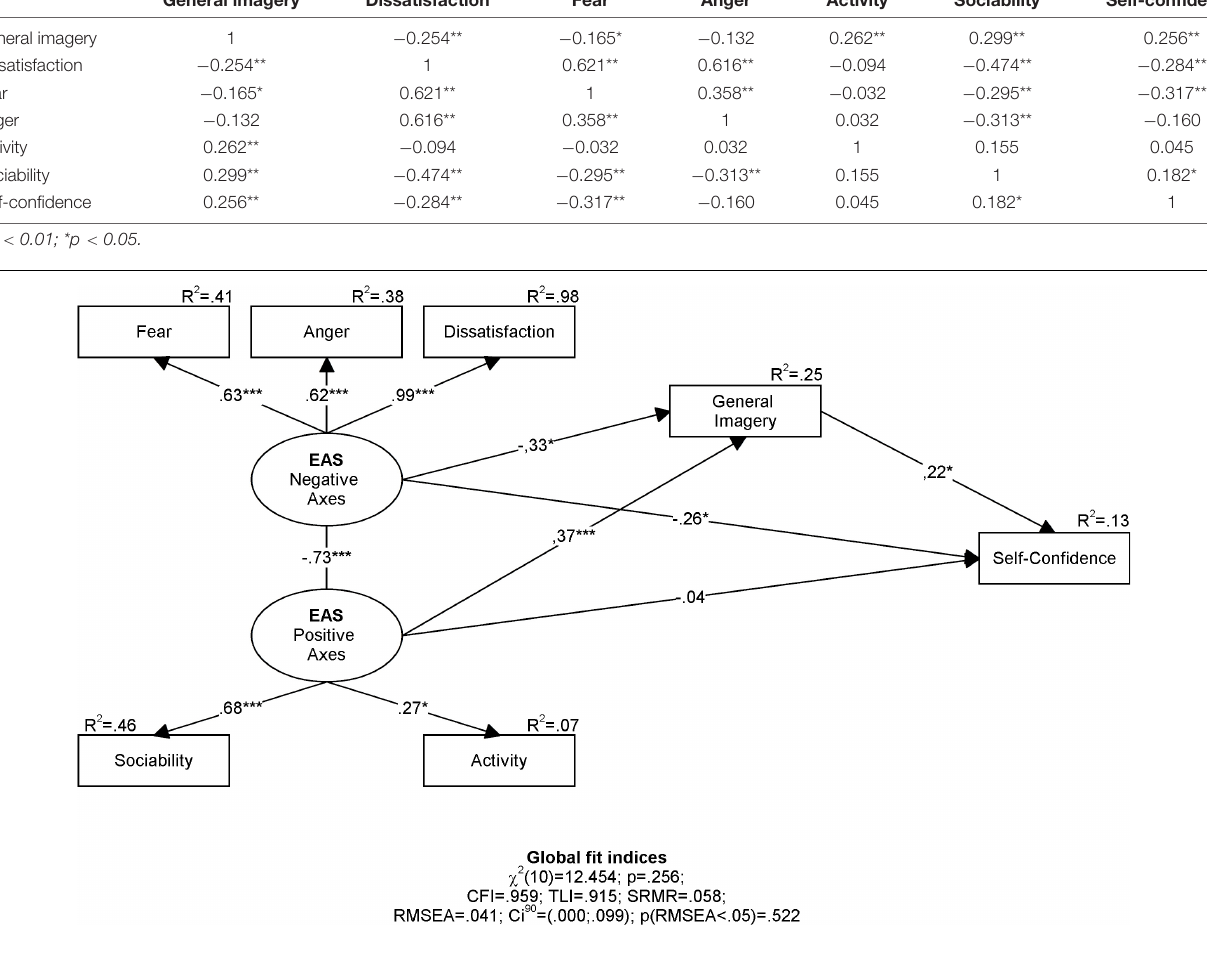
FIGURE 1 | Result diagram of SEM model estimated in athletes sample ( N = 144). * p < 0.05, ** p < 0.01, *** p <